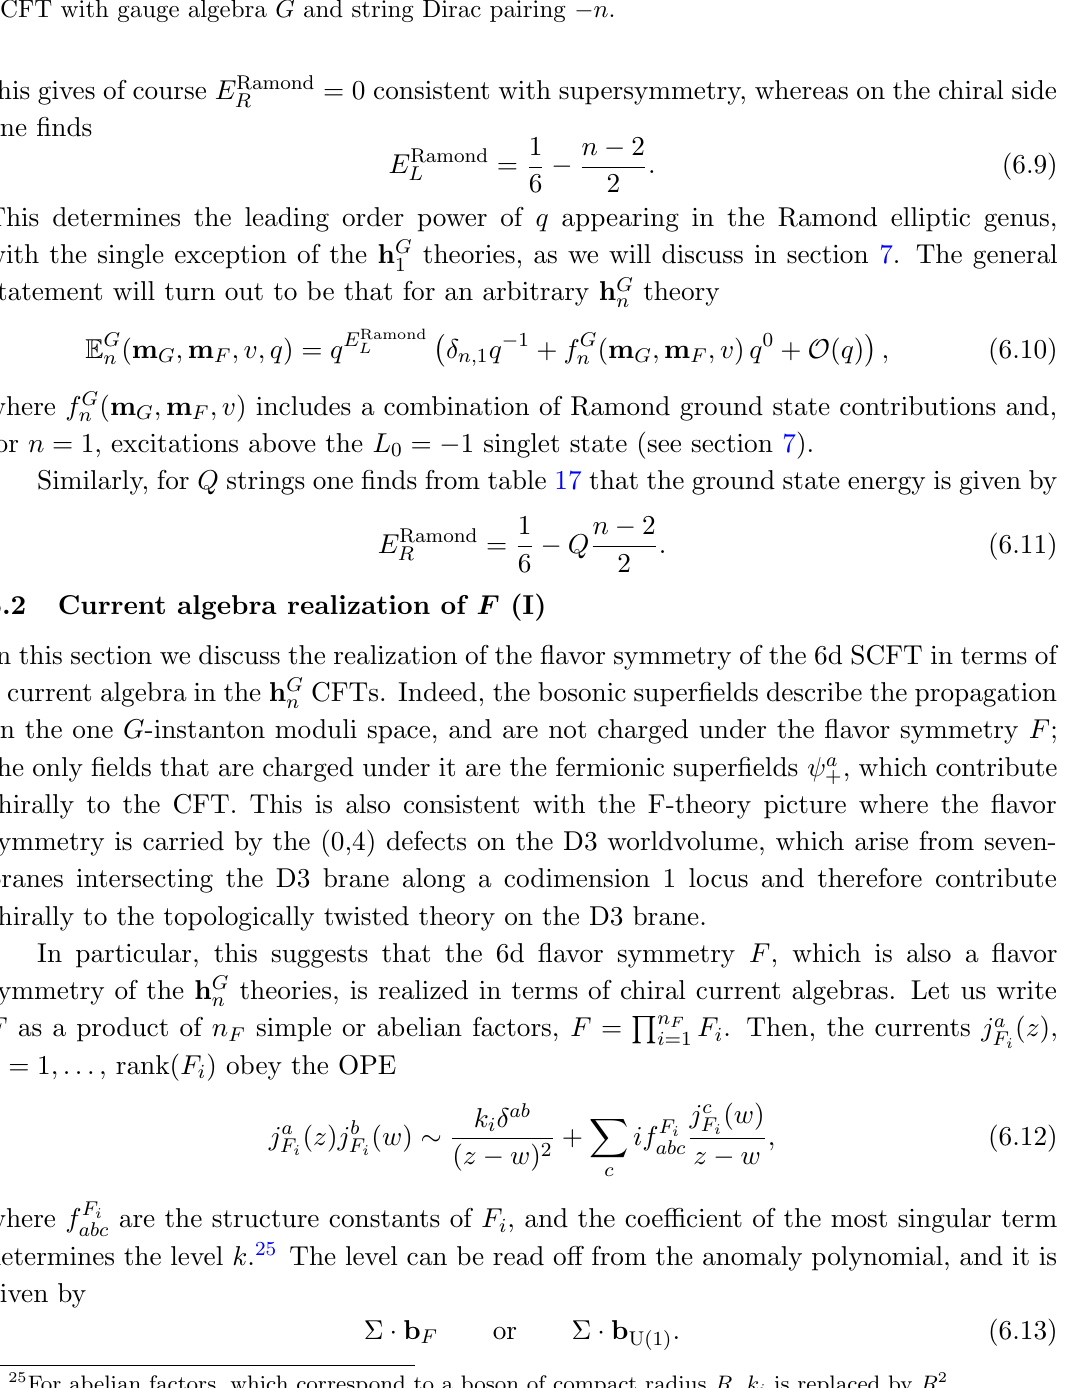
Table 17. Degrees of freedom of the NLSM describing a bound states of Q strings for the 6d (1,0) SCFT with gauge algebra G and string Dirac pairing (cid:0) n